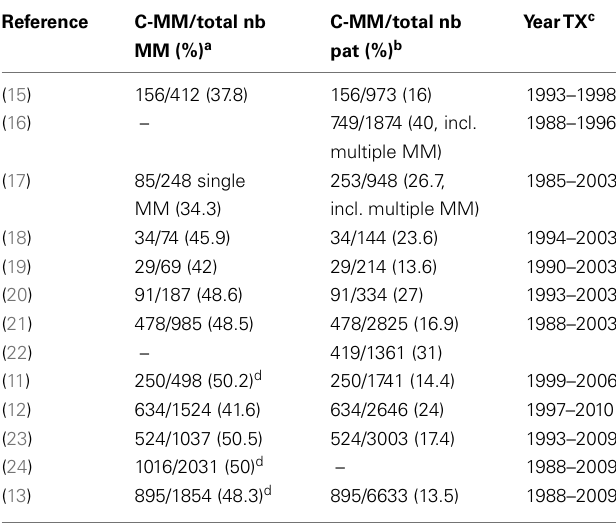
Table 1 | Rate of HLA-C mismatches (MM) in different unrelated HSCT cohorts